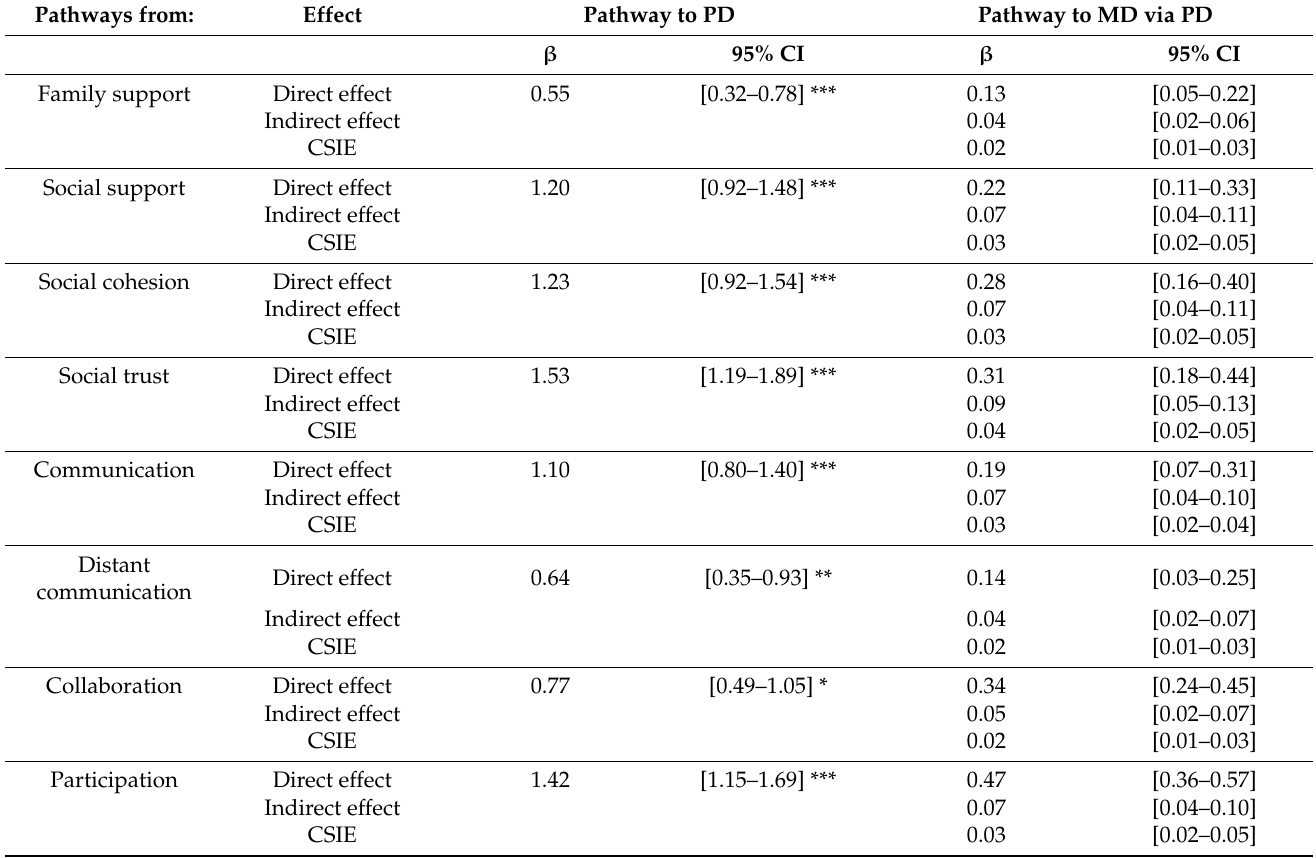
Table 4. Direct and indirect effects of social capital indicators on psychological distress (direct) and adherence to the Mediterranean diet